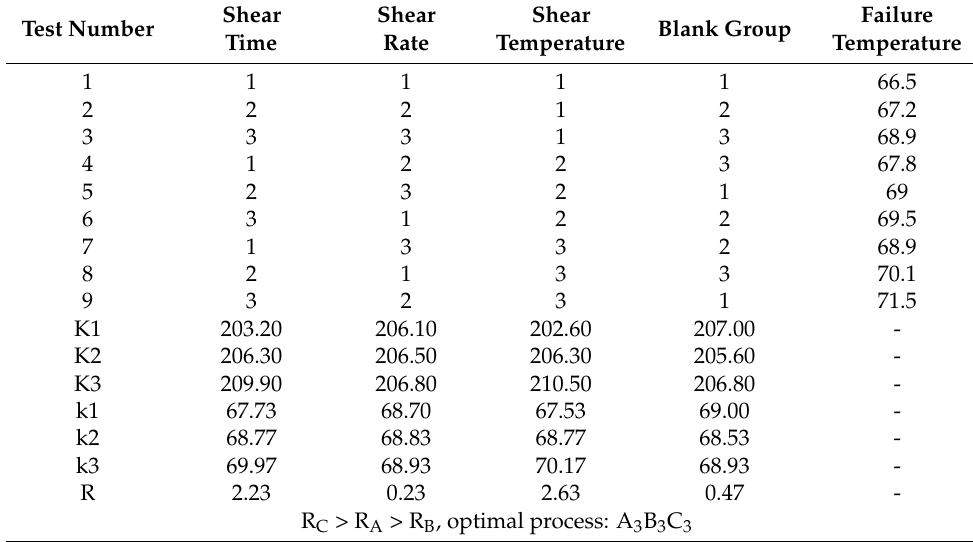
Table 5. Failure temperature range analysis results.